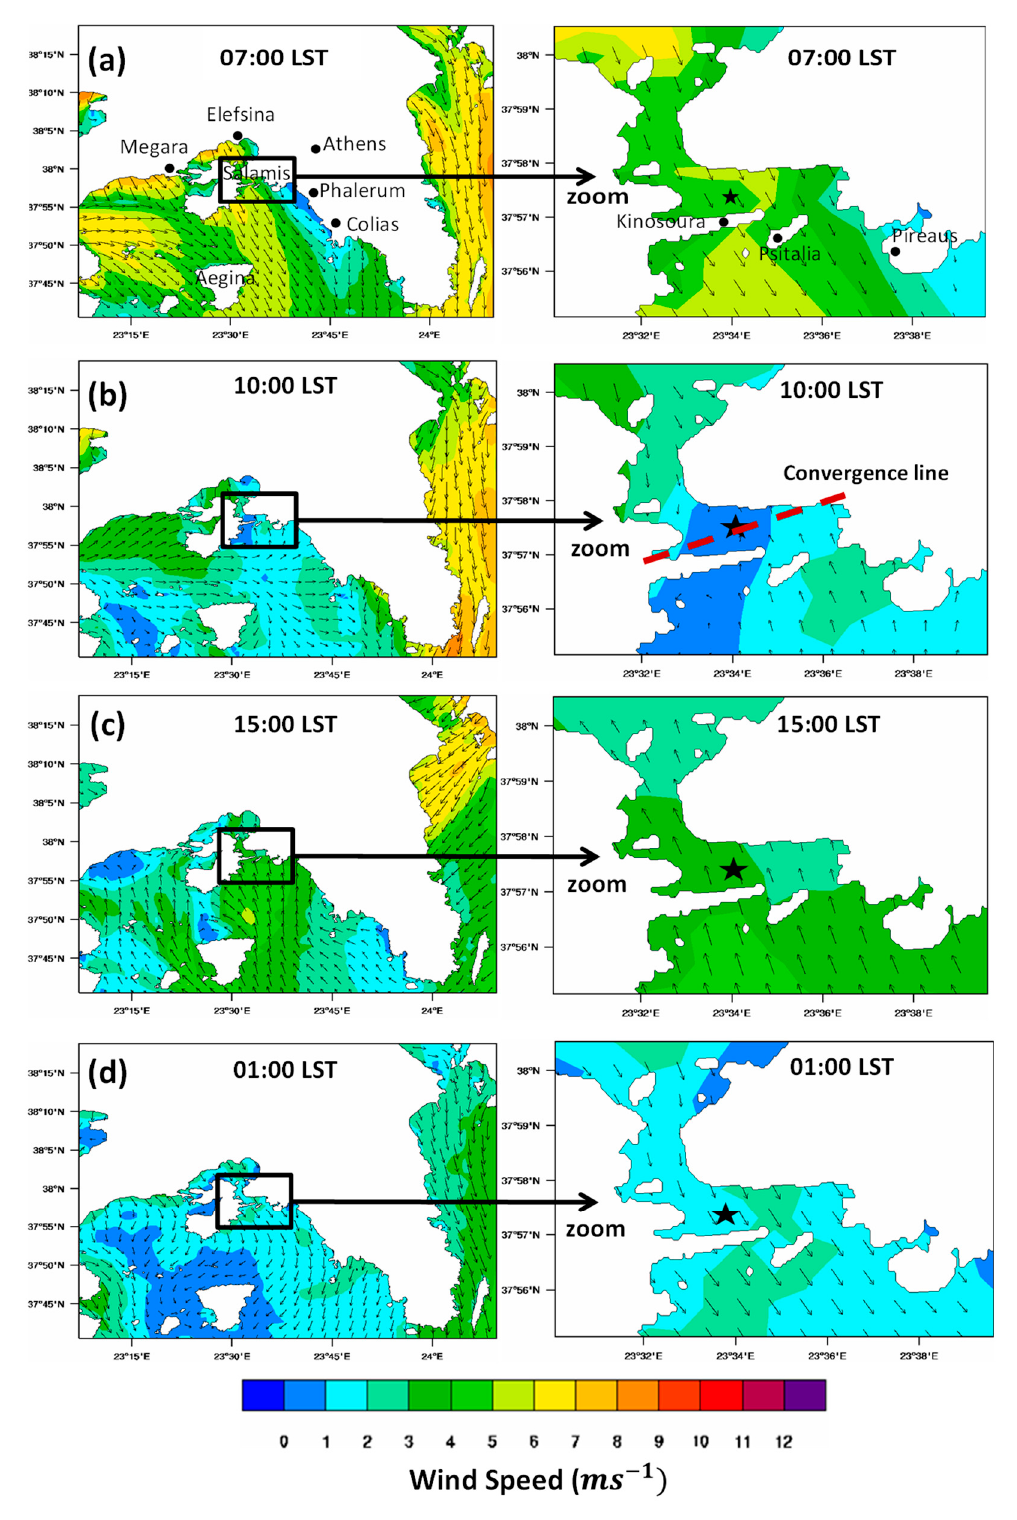
Figure 6. Wind speed (color scale) and direction (vectors) at 10 m (in ms − 1 ) at: ( a ) 07:00 LST, ( b ) 10:00 LST, ( c ) 15:00 LST and ( d ) 01:00 LST. Ten-year average (2007–2016) from WRF inner grid at 1 × 1 km grid space driven by the ERA5 monthly average fields for September. Black star in the zoom plots denotes the location of the diurnal wind course that is shown in Figure 8. Red dashes at 10:00 LST indicate the convergence line between the NW and SE flows.